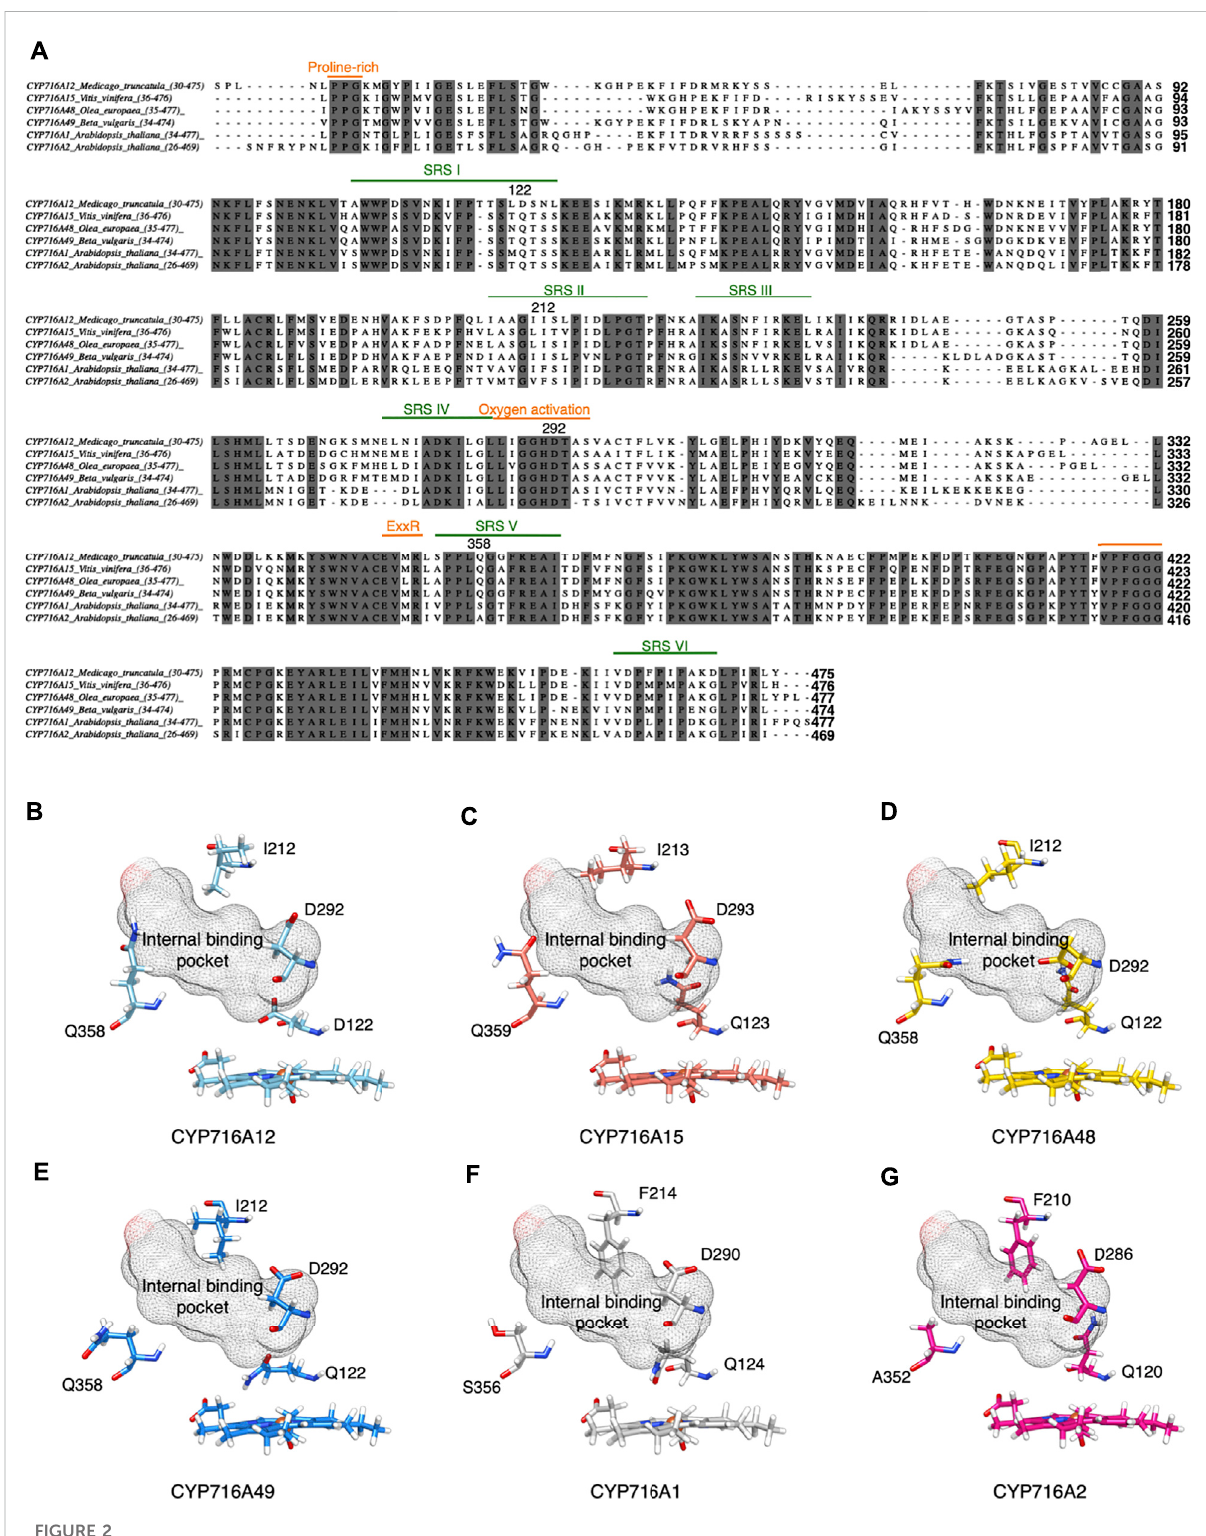
FIGURE 2 Amino acid residues are predicted to be in the substrate recognition sites and signature region via structural alignment of CYP716A12 and selected CYP716As. Structural alignment of selected CYP716As. (A) Amino acid sequence alignment of CYP716A12 against selected CYP716As with conserved CYP domains relevant to functional analysis. Predicted substrate recognition sites (SRS), (green); SRSI (106 – 125); SRSII (207 – 221); SRSIII (227 – 237); SRSIV (276 – 286); SRSV (354 – 365); SRSVI (460 – 469), and Signature region (orange); Protein rich (35 – 37); Oxygen activation (287 – 295); ExxR (349 – 352); PREF (403 – 406); Heme-Binding (417 – 428) are labeled. Comparison of focusing residues on catalytic activity site of (B) CYP716A12 against (C) CYP716A15, (D) CYP716A48, (E) CYP716A49, (F) CYP716A1, and (G)